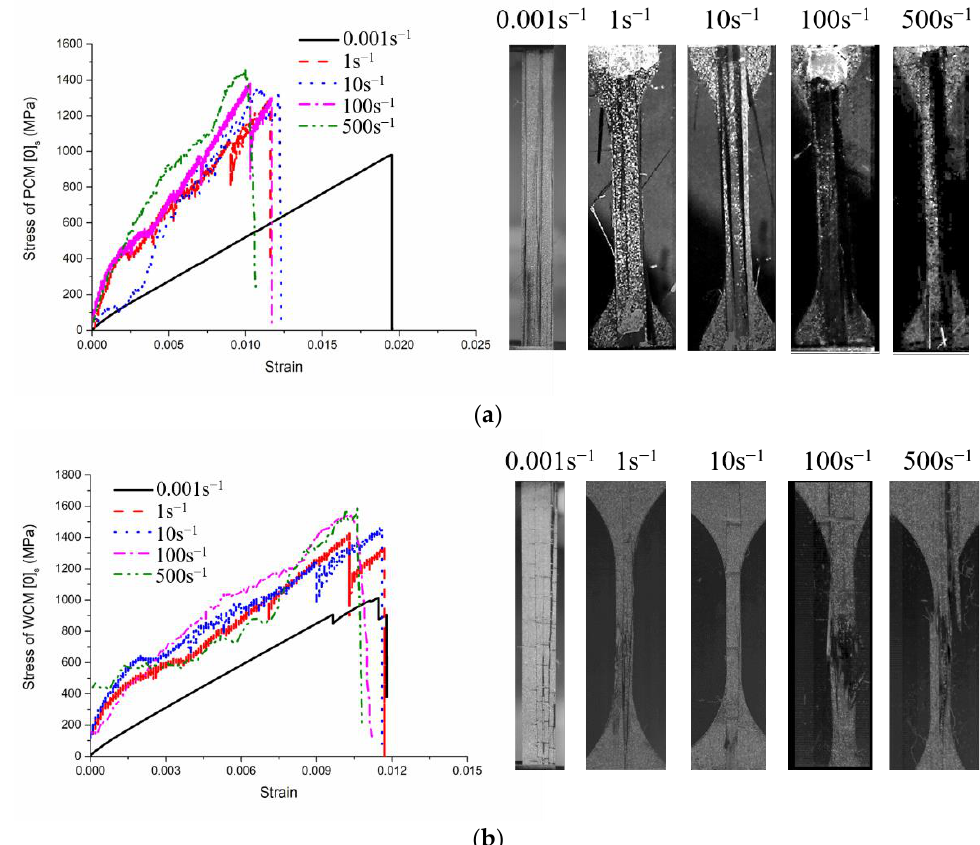
Figure 3. Tensile stress–strain curve and fracture images of (0)s configuration made using ( a ) PCM and ( b )